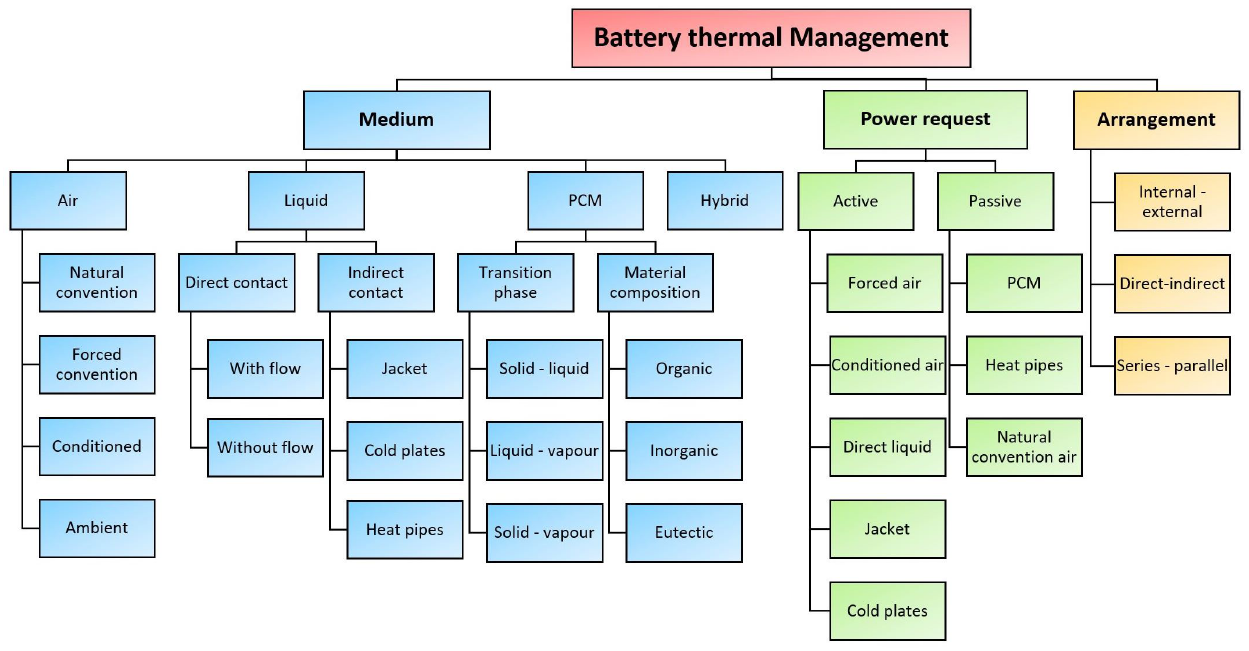
Figure 7. Classifications of battery thermal management systems (based on